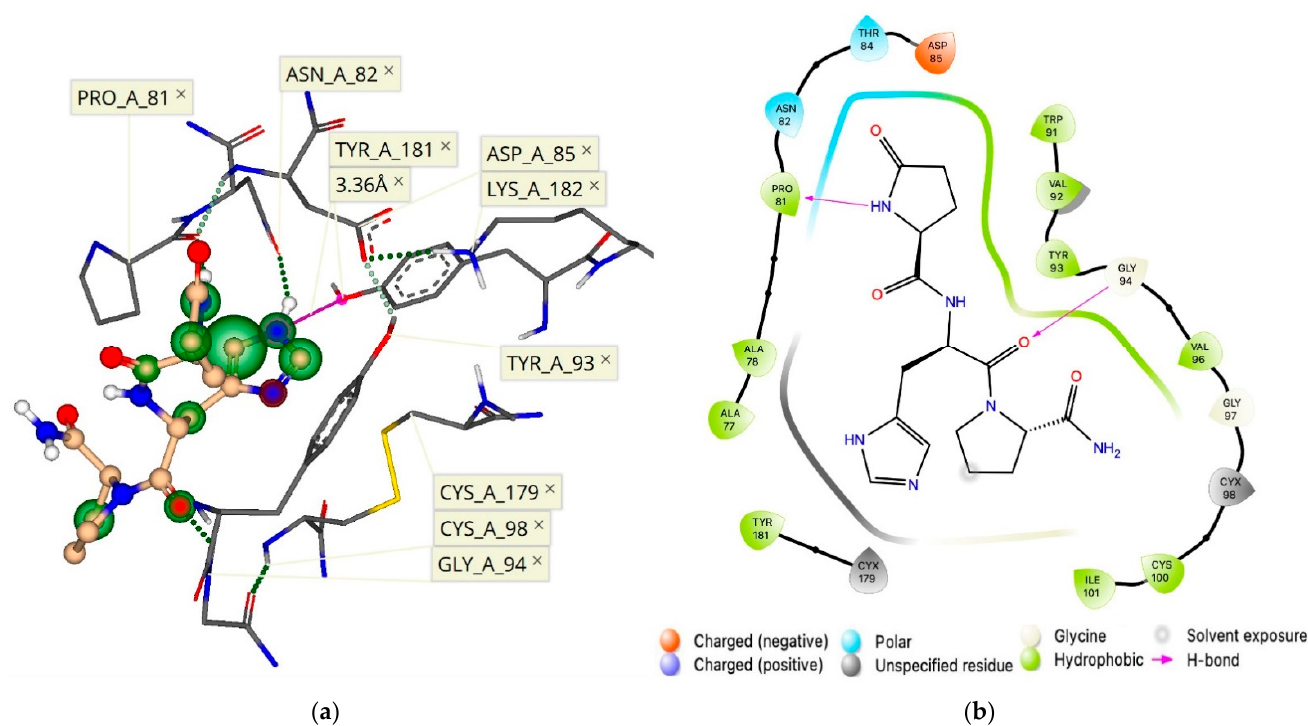
Figure 5. ( a ) Three-dimensional and ( b ) two-dimensional pharmacophore models of TRH docked to the proposed recog- nition binding site at the hTRH-R surface.